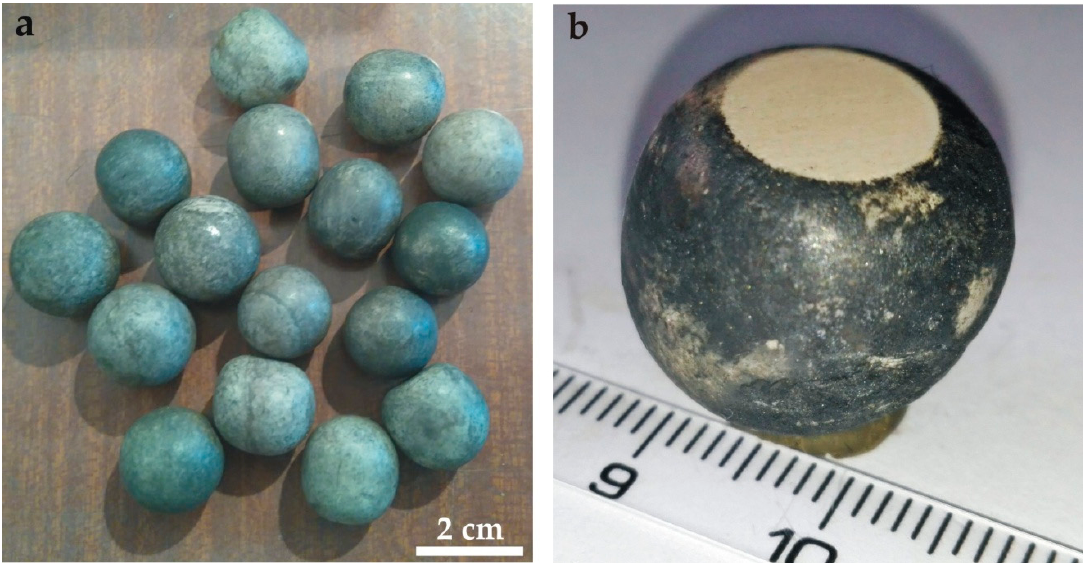
Figure 3. ( a ) Group of fake calcite spheres exhibited at a mineral show in Cluj-Napoca (Romania) in 2016; ( b ) Jamesonite detritus and needles are glued onto the surface of synthetic aluminum oxide (Al 2 O 3 ) + spinel balls, as identified by [35] based on XRD data.